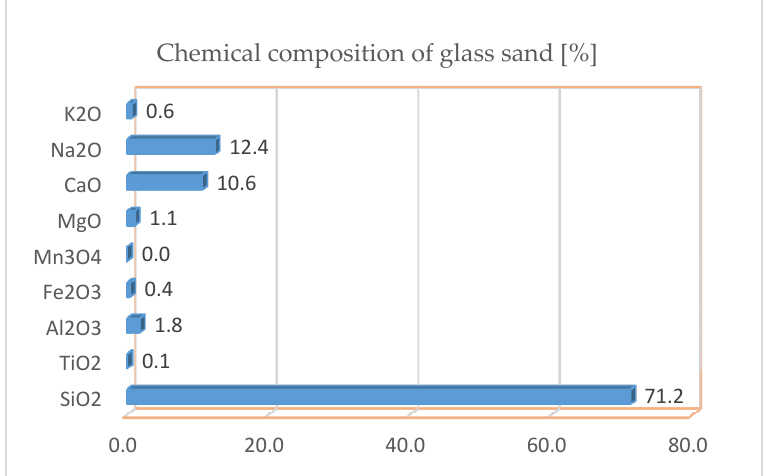
Figure 6. Chemical composition of glass sand used to modify sand-lime bricks (% by mass).